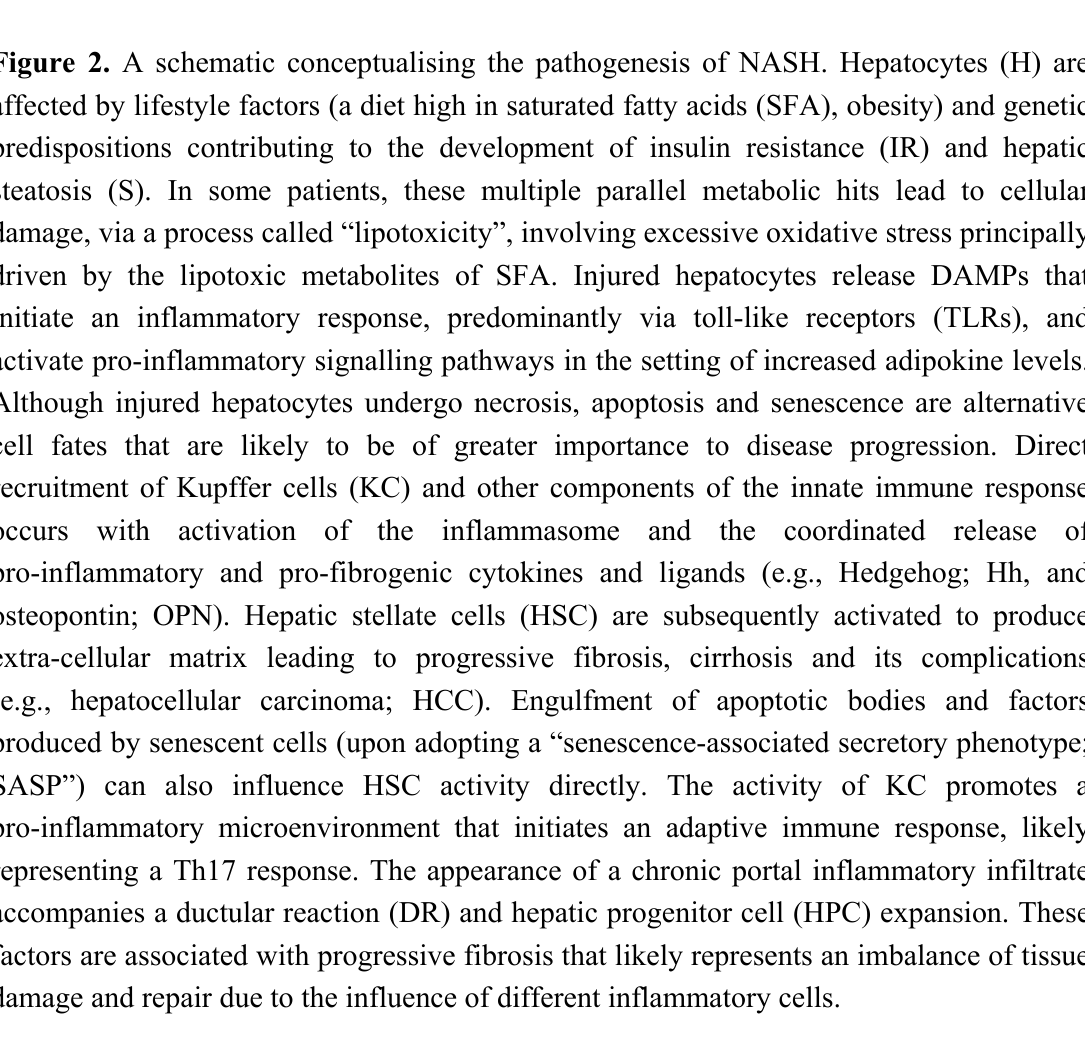
Figure 2. A schematic conceptualising the pathogenesis of NASH. Hepatocytes (H) are affected by lifestyle factors (a diet high in saturated fatty acids (SFA), obesity) and